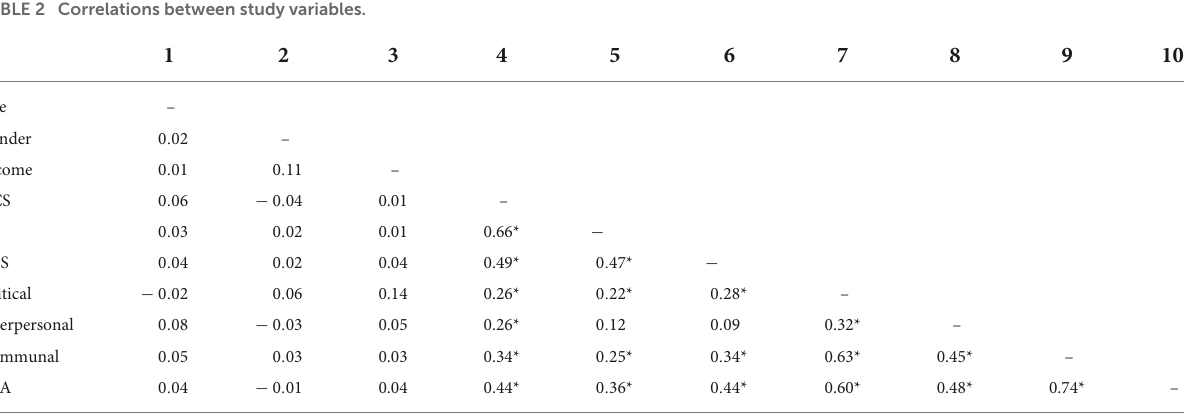
TABLE 2 Correlations between study variables.